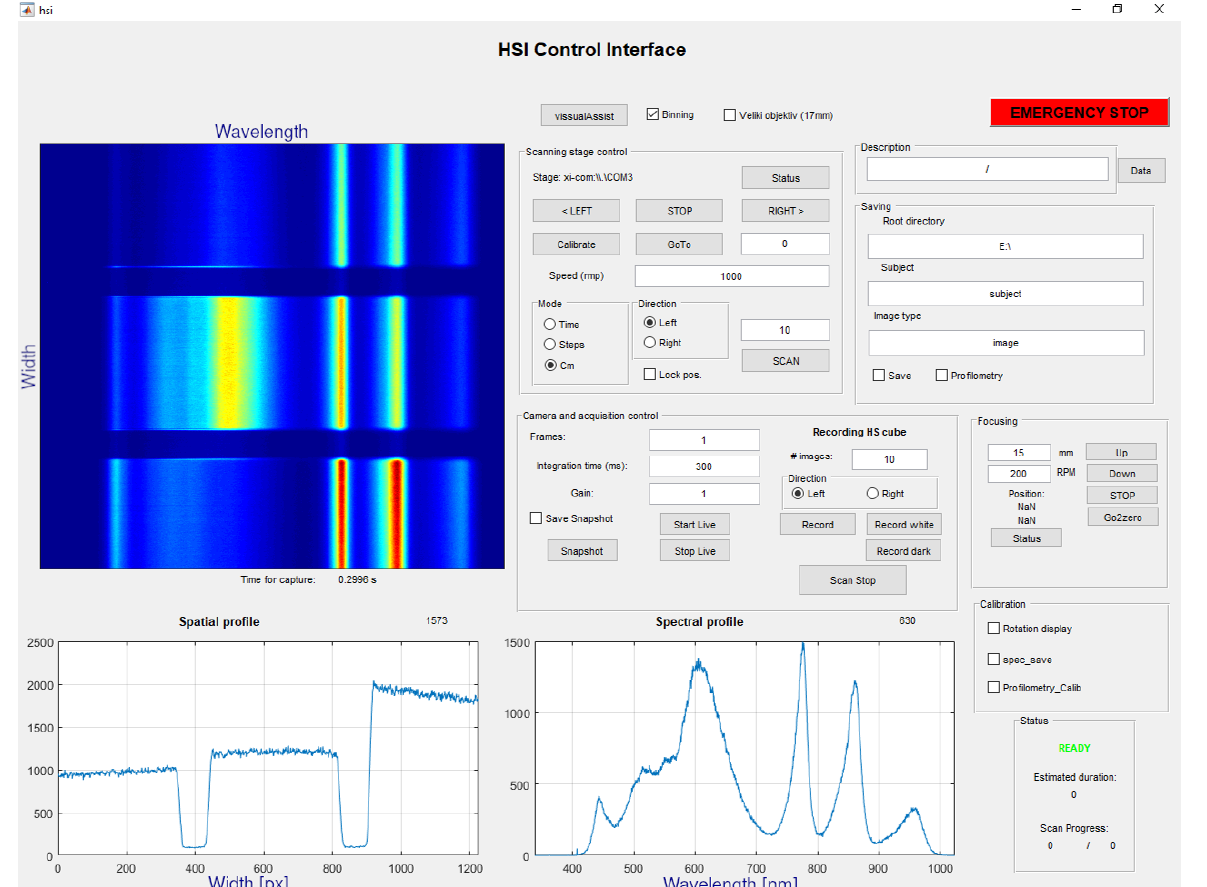
Figure A2. Screenshot of the acquisition software of the custom-made hyperspectral imaging (HSI) system. Control software implemented in MATLAB is showing a color standard (ColorChecker Passport, X-Rite Inc., Grand Rapids, MI, USA). At the bottom, the spectral view and spatial profile along with the scanning line at approximately 500 nm are shown. Additional clarification labels are added to the screenshot in